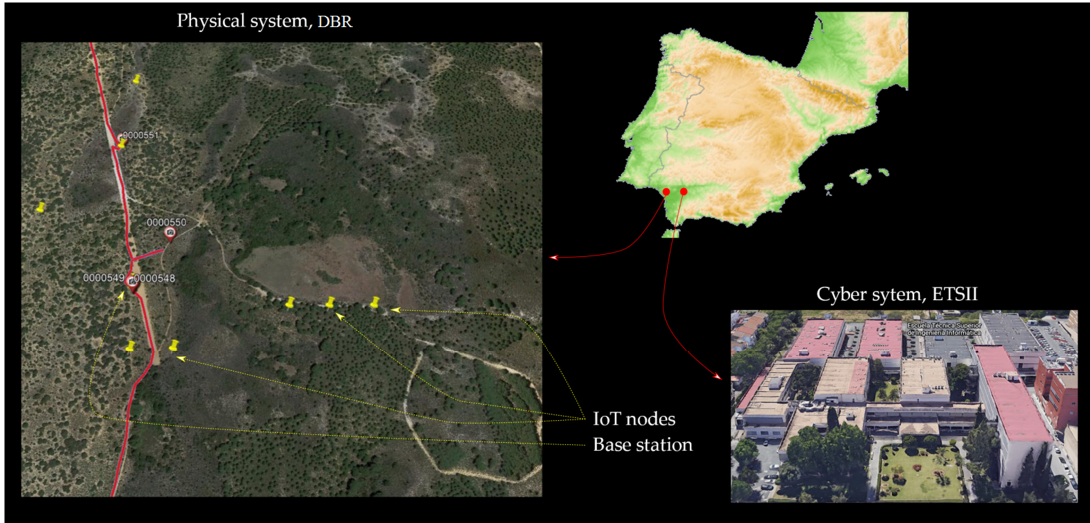
Figure 8. CPS topology. Physical system, DBR, Huelva, Spain; cyber system, ETSII, Sevilla, Spain.